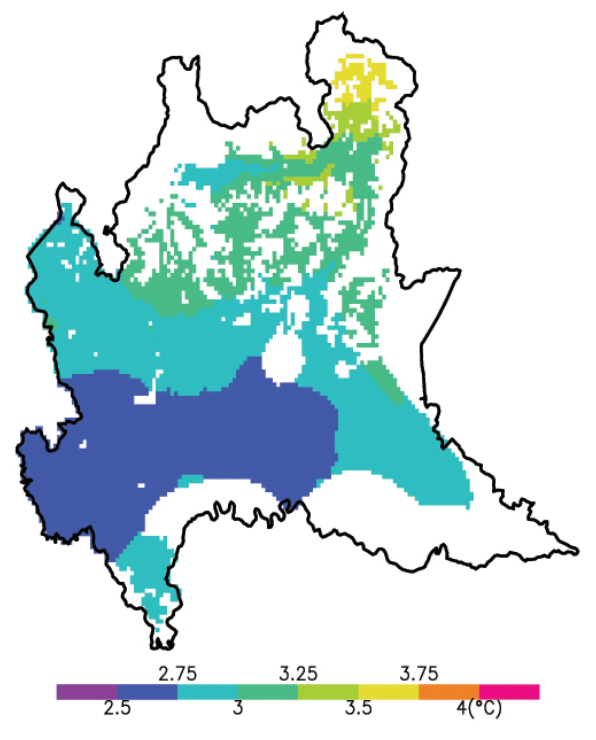
Figure 4. Summer season (June-July-August) averaged σ TX + . The IDI mask has been applied (see Sect.